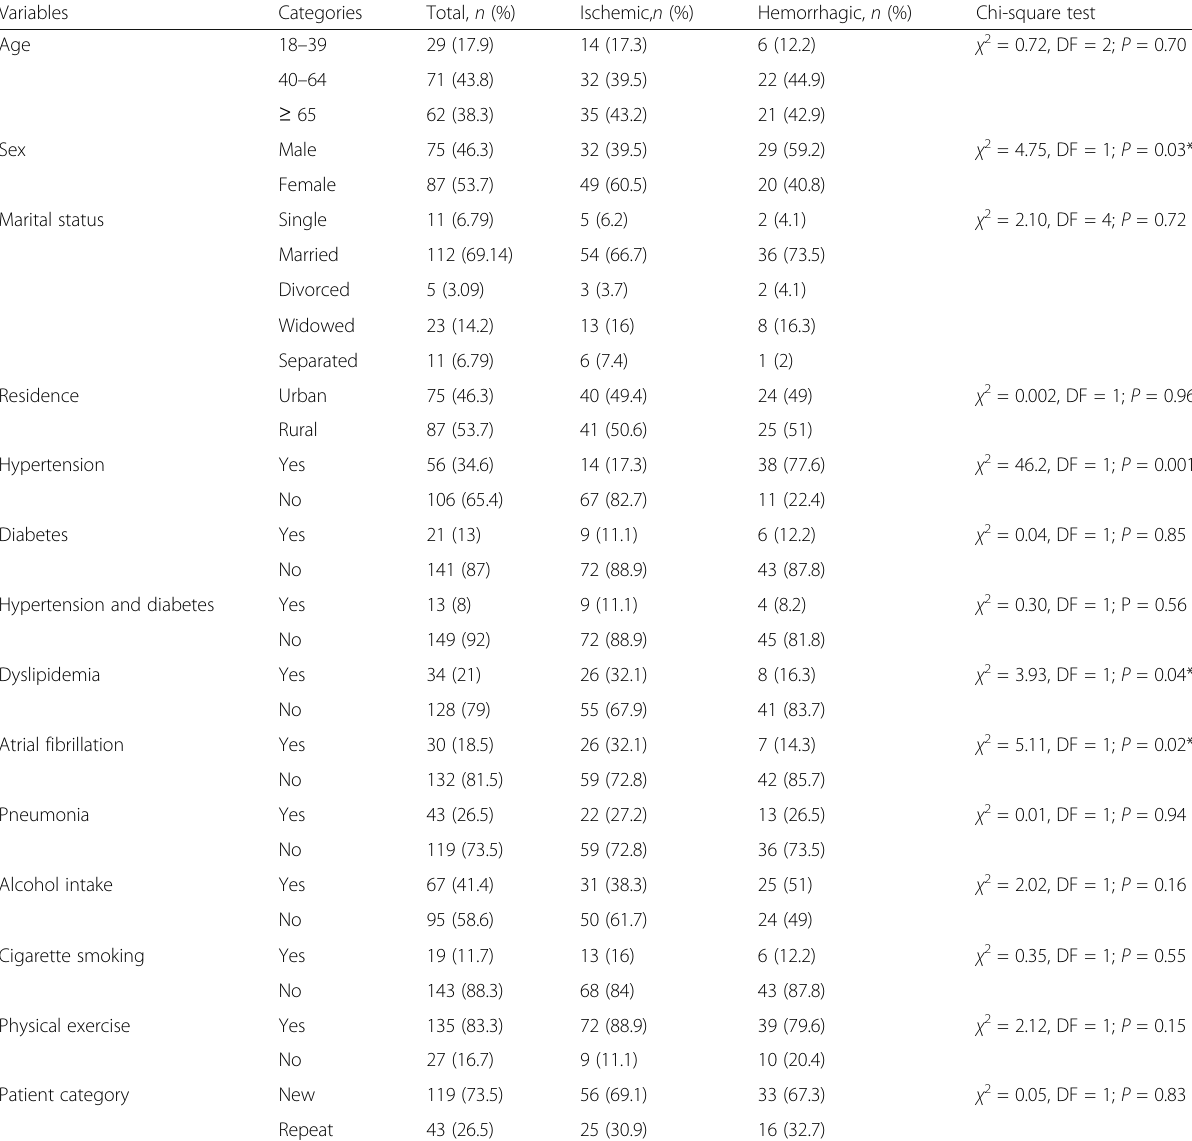
Table 3 Association between type of stroke and patient ’ s sociodemographic characteristics in Debre Markos referral hospitals, Northwest Ethiopia, 2017 –